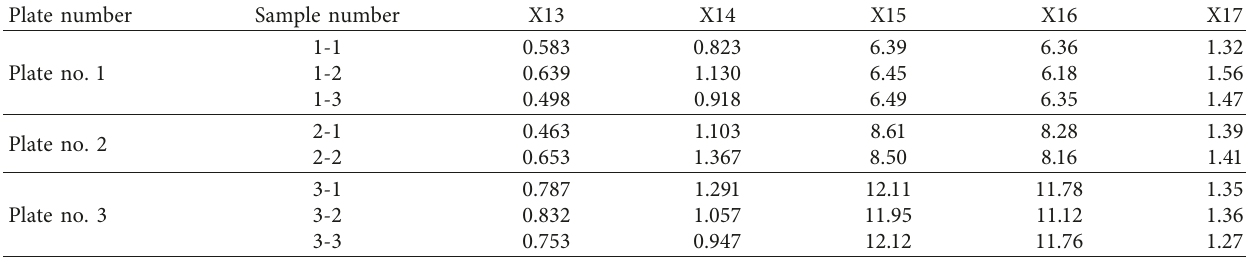
Plate number Plate no. 1 Plate no. 2